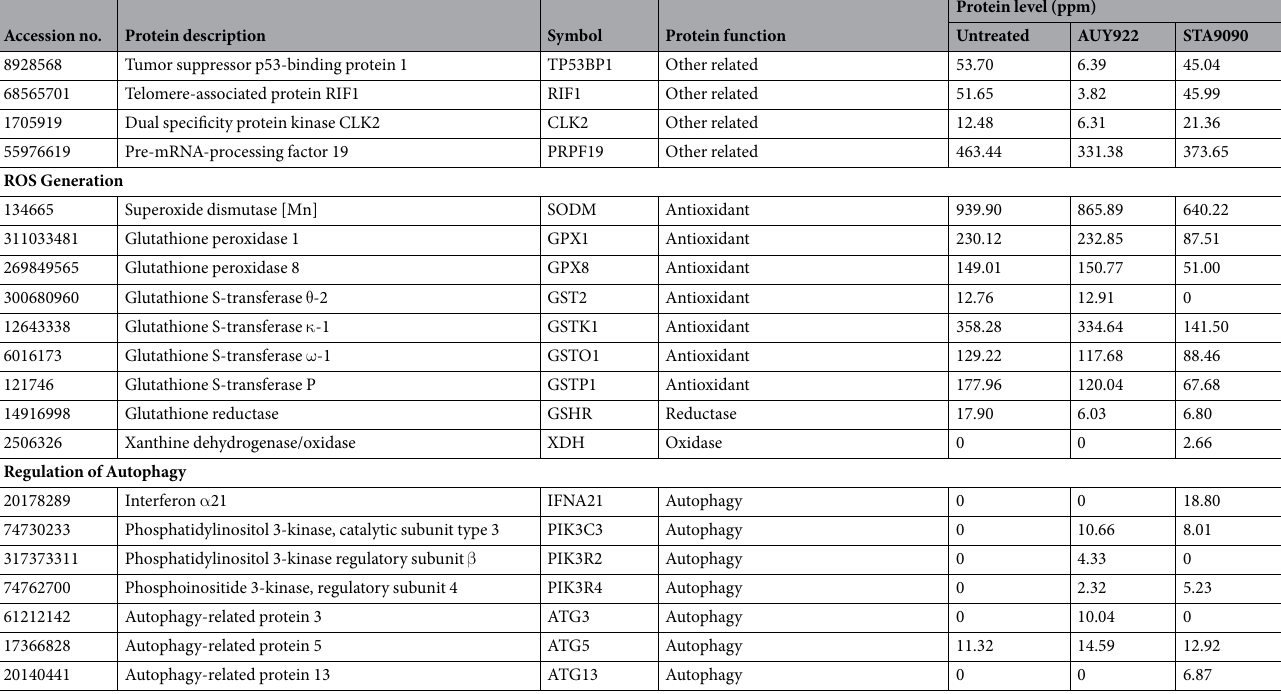
Table 3. Alterations in the levels of the proteins associated with cell death in bladder carcinoma 5637 cells in response to treatment with the heat shock protein 90 inhibitors AUY922 and ganetespib (STA9090). ROS, reactive oxygen